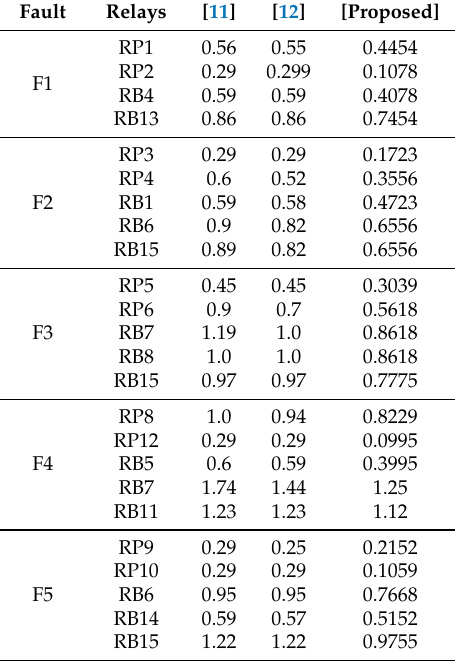
Table 6. Operation times for